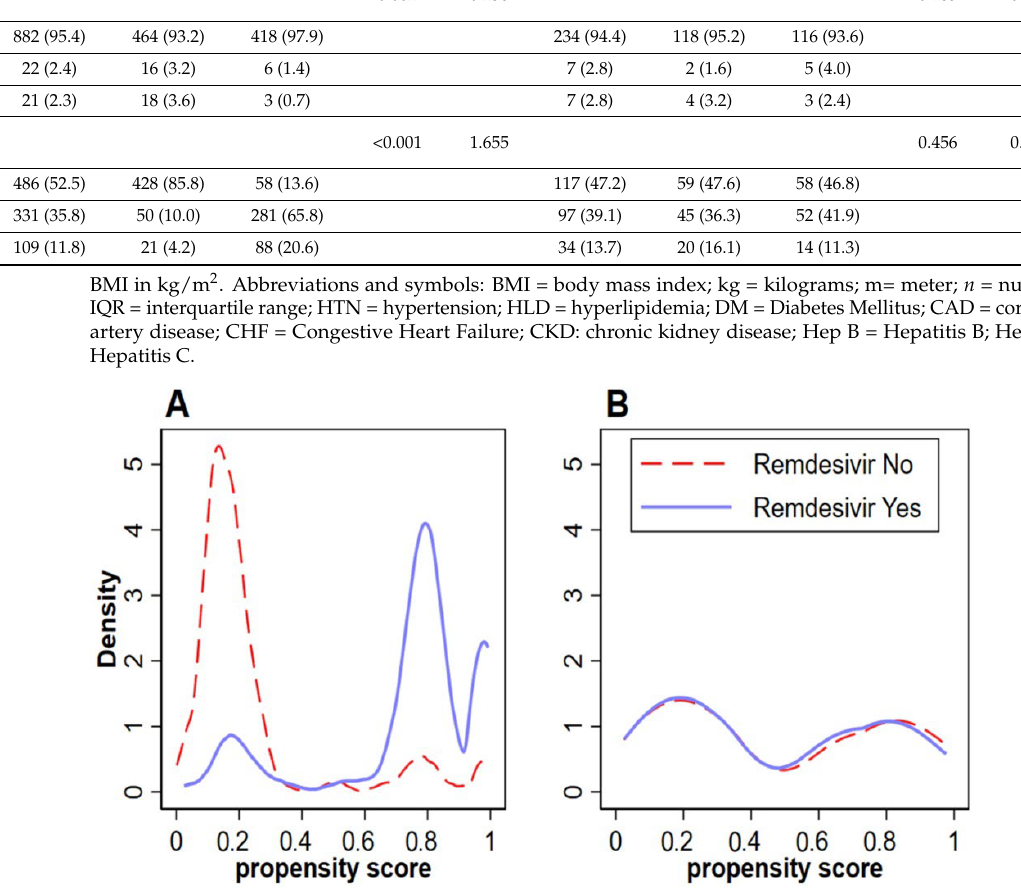
Figure 1. Density of Propensity Scores ( A ): Before Matching, ( B ): After Matching without Replace- ment.